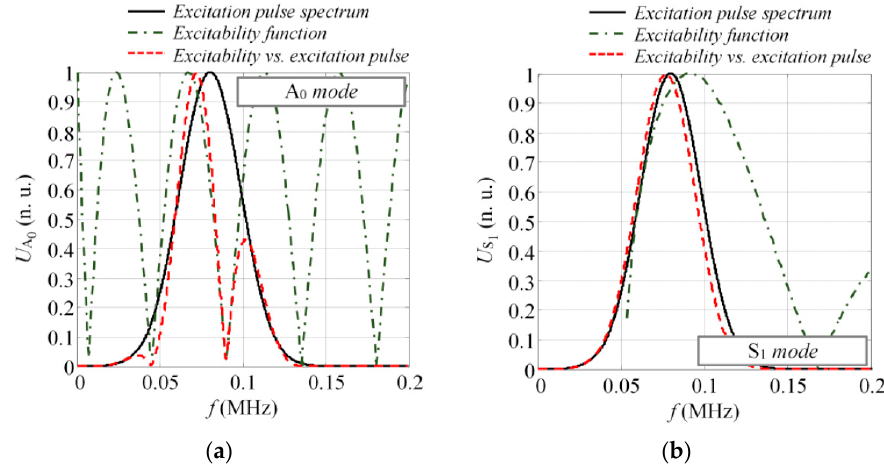
Figure 5. The influence of the excitability function to the frequency response of the guided waves for the asymmetric A 0 ( a ) and symmetric S 1 ( b ) modes (solid line: spectrum of the excitation pulse, dash-dot line: excitability function, dashed line: product of excitation pulse and excitability function).